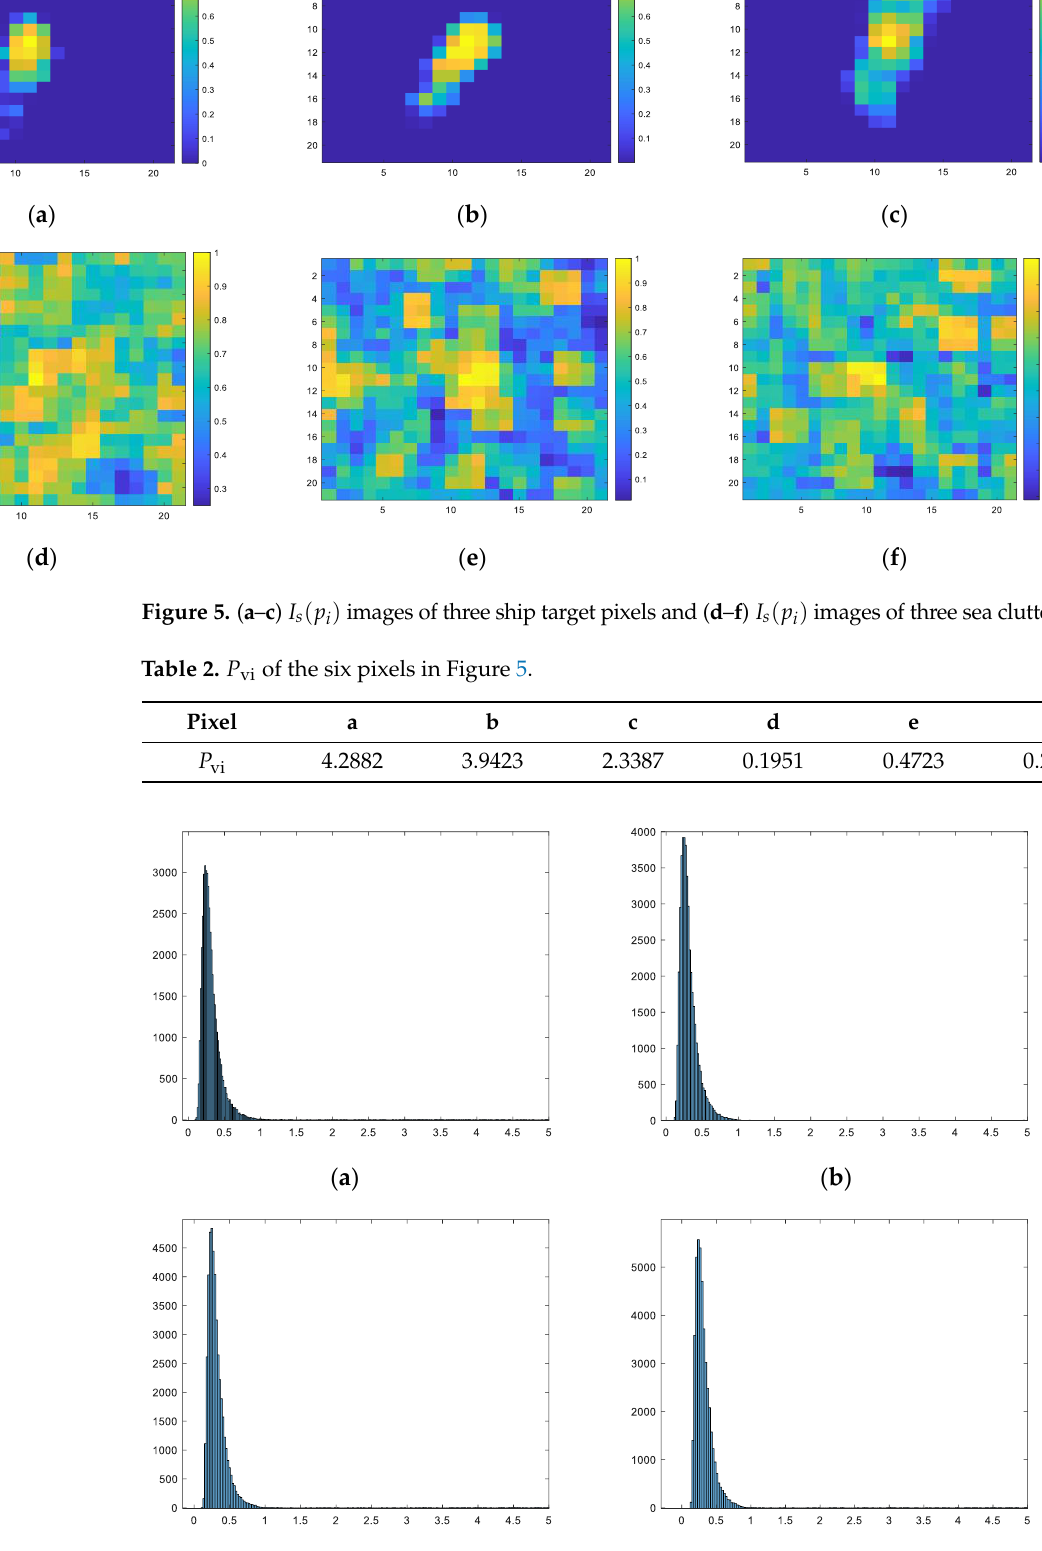
Figure 6. Histogram of 𝑃 vi under different patch sizes: ( a – d ) patch size = 15, 19, 23, 27.